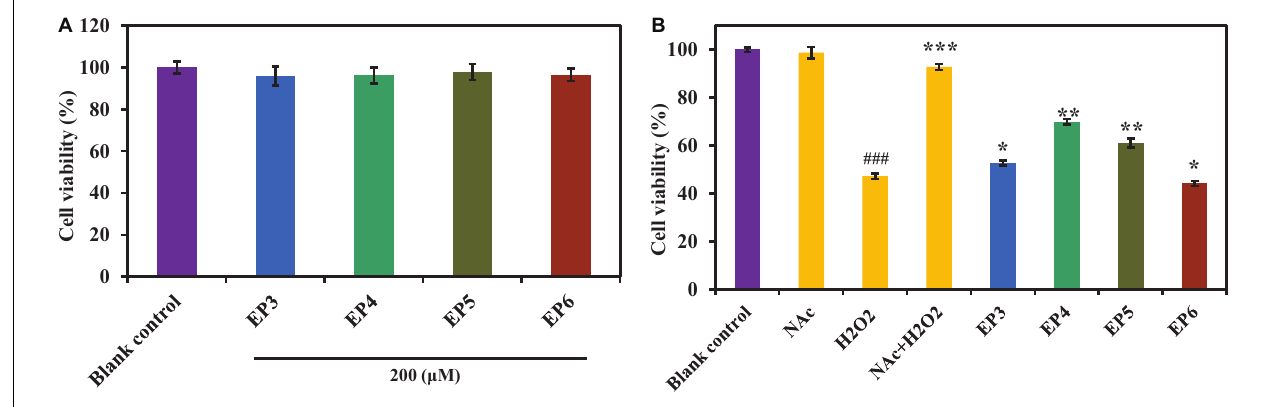
FIGURE 6 | Effects of the antioxidant peptides (EP3–EP6) on HUVEC viabilities (A) and their protective effects against oxidative damage in H 2 O 2 -induced HUVEC model (B) . Blank control refers to the viability of the normal cells without any treatment; Acetylcysteine (NAc) at the concentration of 100 µ m was used as the positive control; H 2 O 2 refers to H 2 O 2 -induced oxidative damaged model (300 µ m for 6 h); NAc + H 2 O 2 refers to NAc treated with H 2 O 2 -induced HUVECs at the concentration of 100 µ m; peptide + H 2 O 2 refers to EP3–EP6 treated with H 2 O 2 -induced HUVECs at the concentration of 200 µ m, respectively. All data were presented as the mean ± SD ( n = 3). (A) Values in each column have no significant difference ( p > 0.05). (B) ### p < 0.001 vs. the blank control group; ∗∗∗ p < 0.001, ∗∗ p < 0.01, and ∗ p < 0.05 vs. the H 2 O 2 -treated group.